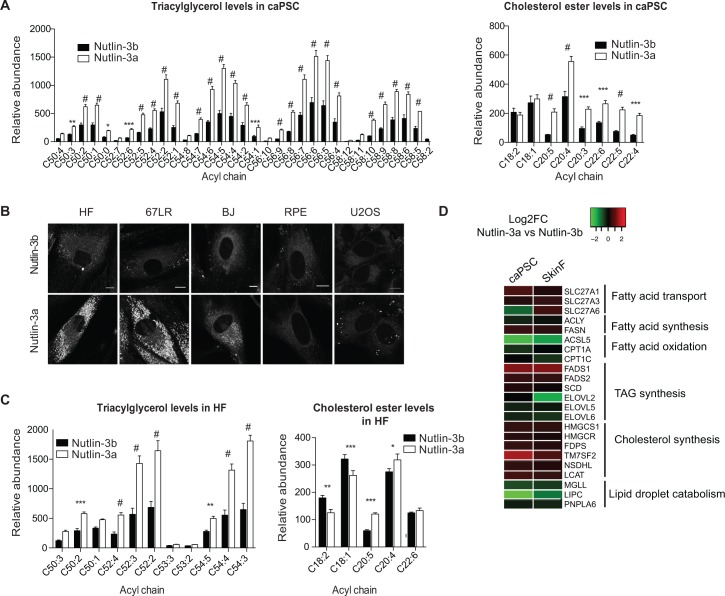
p53-induced lipid droplet accumulation is associated with an increase in triacylglycerols and cholesterol esters.(A) Relative abundance of selected lipids from mass spectrometry-based lipidomics analysis of caPSC-82 treated for 72h with Nutlin-3a or Nutlin-3b (control). Bar graphs represent mean +SD of triplicates. #, p<0.0001; ***, p<0.001; **, p<0.01; *, p<0.05 by two-way ANOVA. (B) Representative images of cells treated with Nutlin-3a or Nutlin-3b for 72h and stained with BODIPY 493/503. Scale bar, 10 μM. (C) Relative abundance of selected lipids from mass spectrometry-based lipidomic analysis of the skin fibroblast line HF treated for 72h with Nutlin-3a or Nutlin-3b. Data are represented as in A. (D) Heatmap representing selected genes from the RNA-seq analysis of caPSCs and skin fibroblasts (SkinF). Data are represented as log2 fold change, Nutlin-3a versus Nutlin-3b.